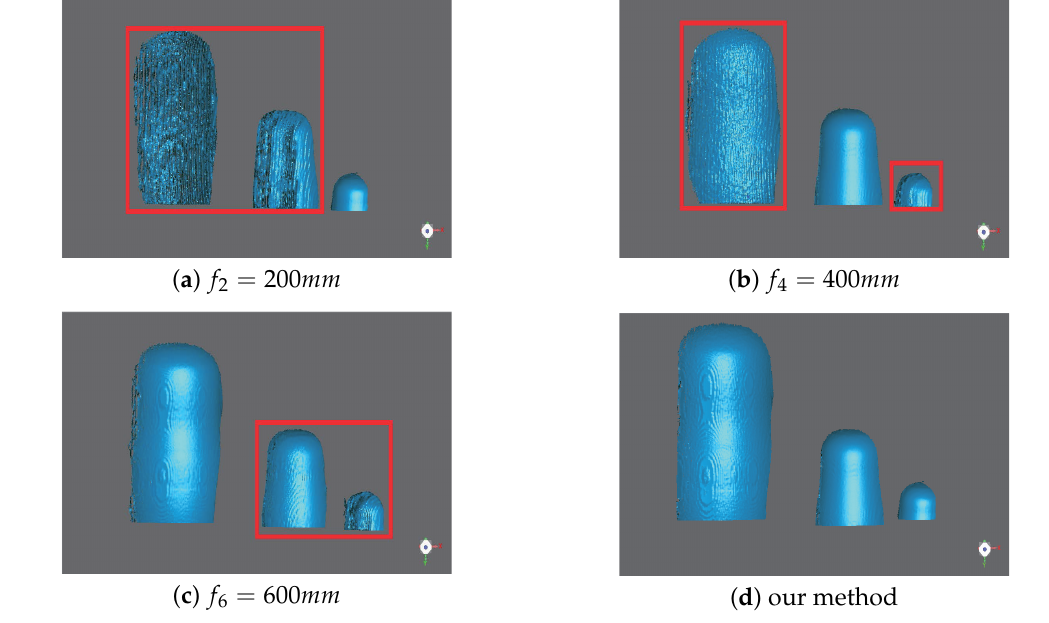
Figure 5. Comparison of measurement results. ( a ) The camera focal distance at f 2 = 200 mm; ( b ) the camera focal distance at f 4 = 400 mm; ( c ) the camera focal distance at f 6 = 600 mm; ( d ) our method.